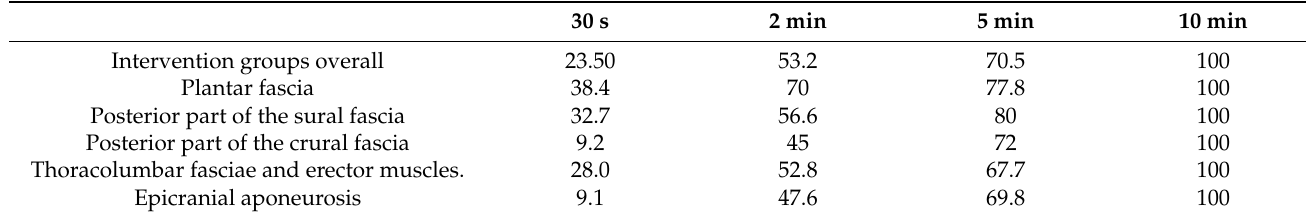
Table 3. Percentage of total flexibility increase achieved at each